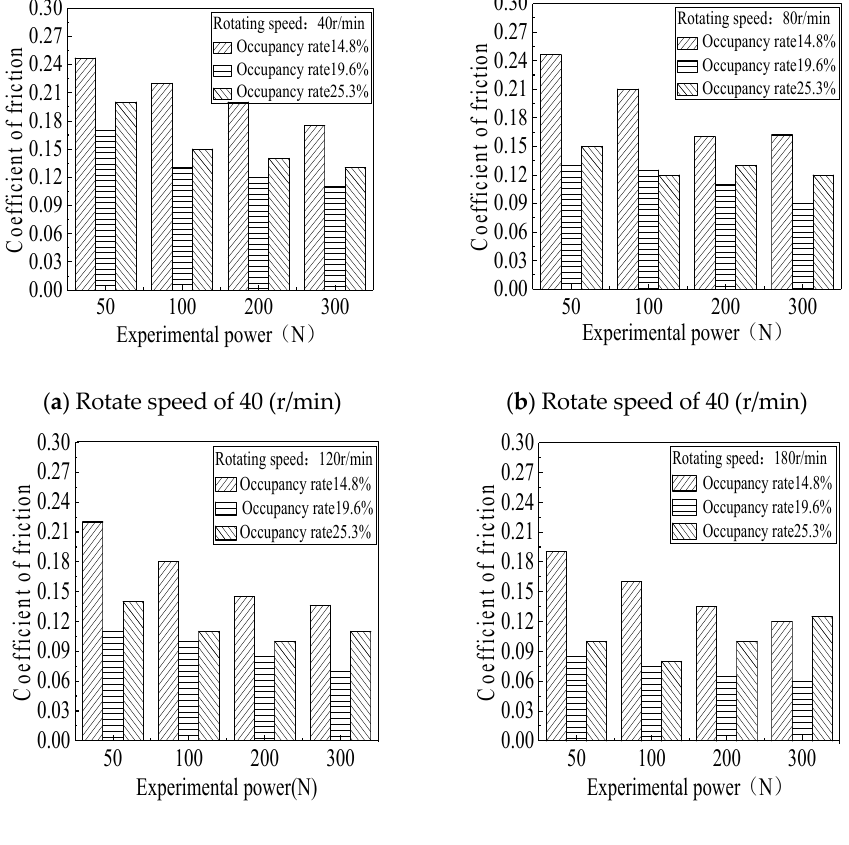
Figure 11. Coefficients of friction corresponding to different occupancy rates.